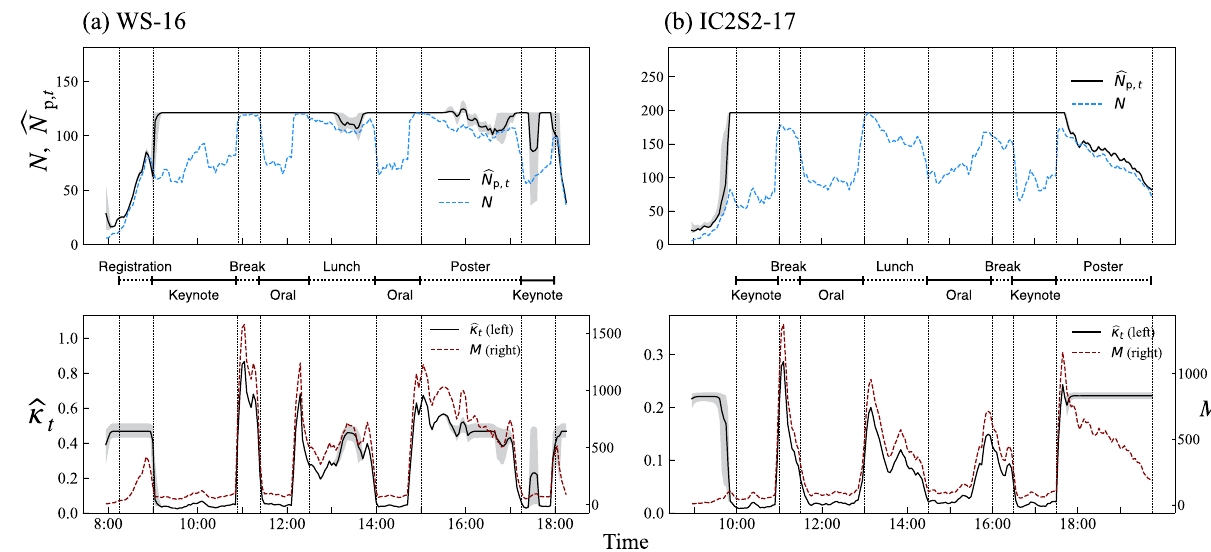
κ t are shown in the upper and the N p, t and (cid:31) (cid:31)